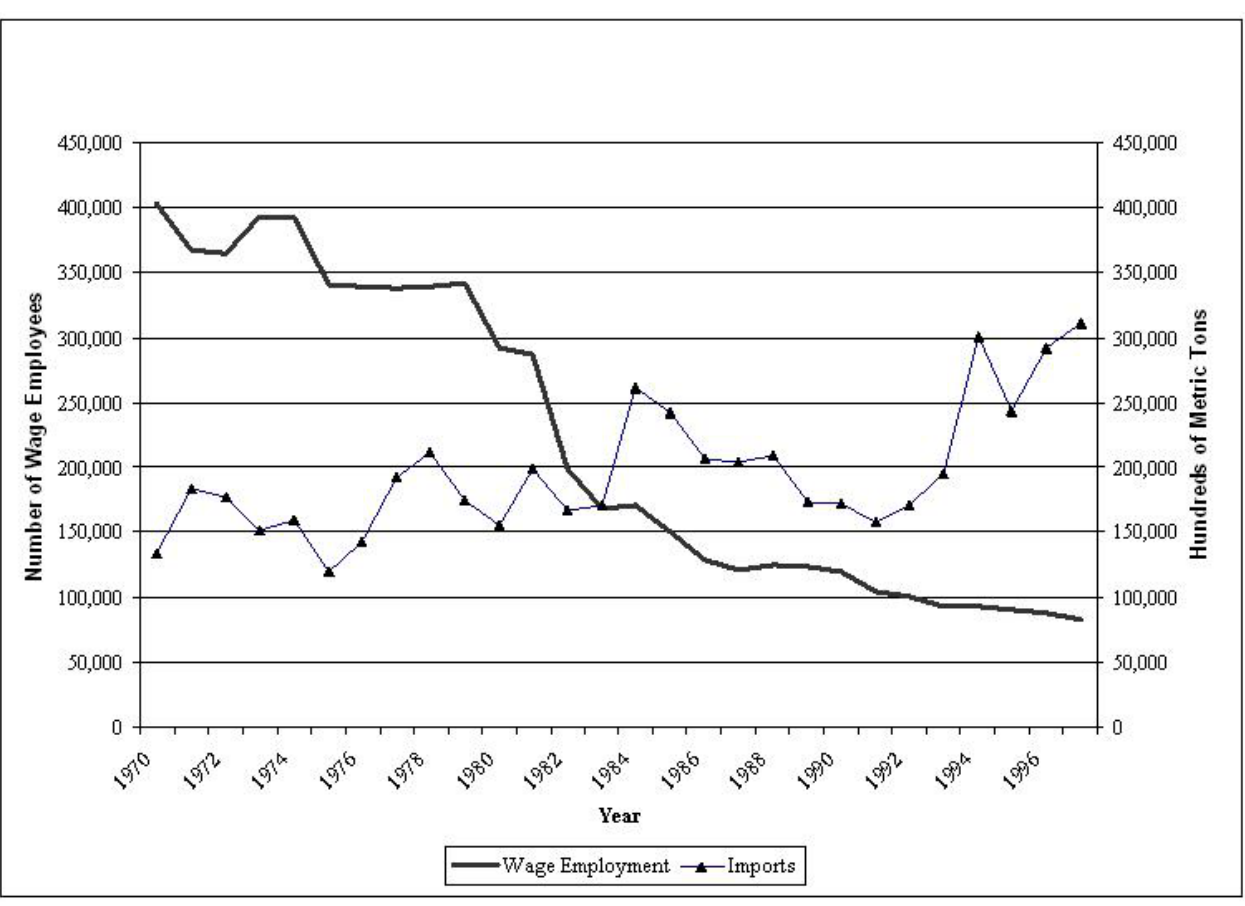
Fig. 3. Wage employment and imports, U.S. steel industry,